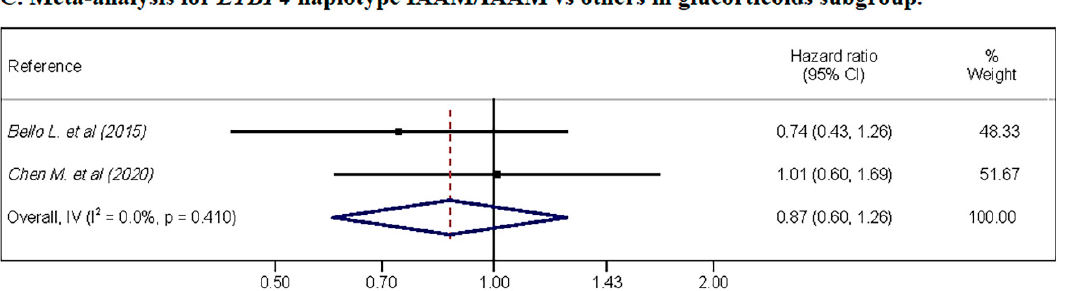
Figure 3. Meta-analyses for hazard ratio of LoA by genetic variant. ( A ) shows the pooled for LTBP4 haplotype IAAM/IAAM vs. others, without glucocorticoids restrictions; ( B ) shows the pooled for SPP1 rs28357094 genotype TT vs. GG/GT, without glucocorticoids restrictions; ( C ) shows the forest plot for LTBP4 haplotype IAAM/IAAM vs. others in glucocorticoids-treated cohorts.